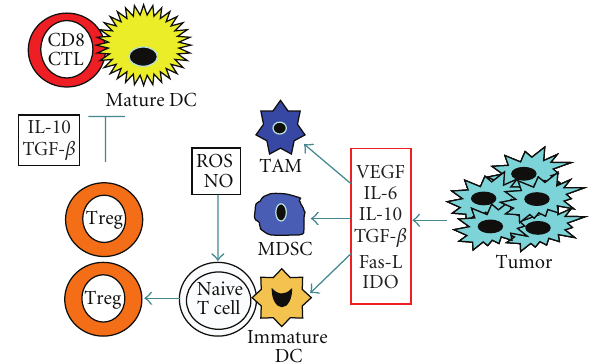
Figure 3: Immunosuppression in tumor microenvironment. Tumors secrete various factors such as VEGF, IL-6, IL-10, TGF- β , Fas-L, and IDO, all of which promote the accumulation of heterogeneous populations of tumor-associated macrophages (TAMs), myeloid-derived suppressor cells (MDSCs), or immature DCs. These immunosuppressive cells inhibit antitumor immunity by various mechanisms, including depletion of arginine and elabo- ration of reactive oxygen species (ROS) and nitrogen oxide (NO). The tumor microenvironment also promotes the accumulation of regulatory T cells (Tregs) that suppress CD8+ CTL function through secretion of IL-10 or TGF- β from Tregs and